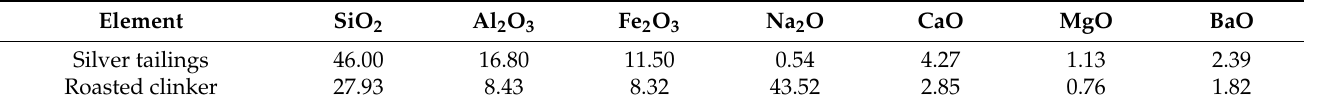
Table 2. Chemical composition of the silver tailings’ roasted clinker